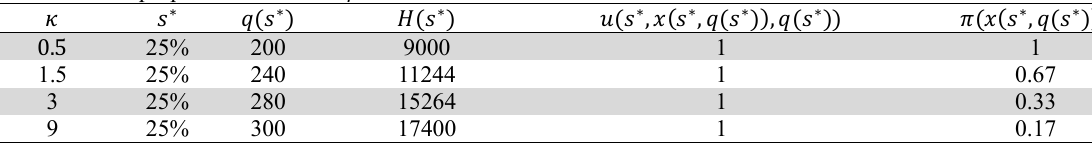
Solutions of the proposed model with 𝜑 =